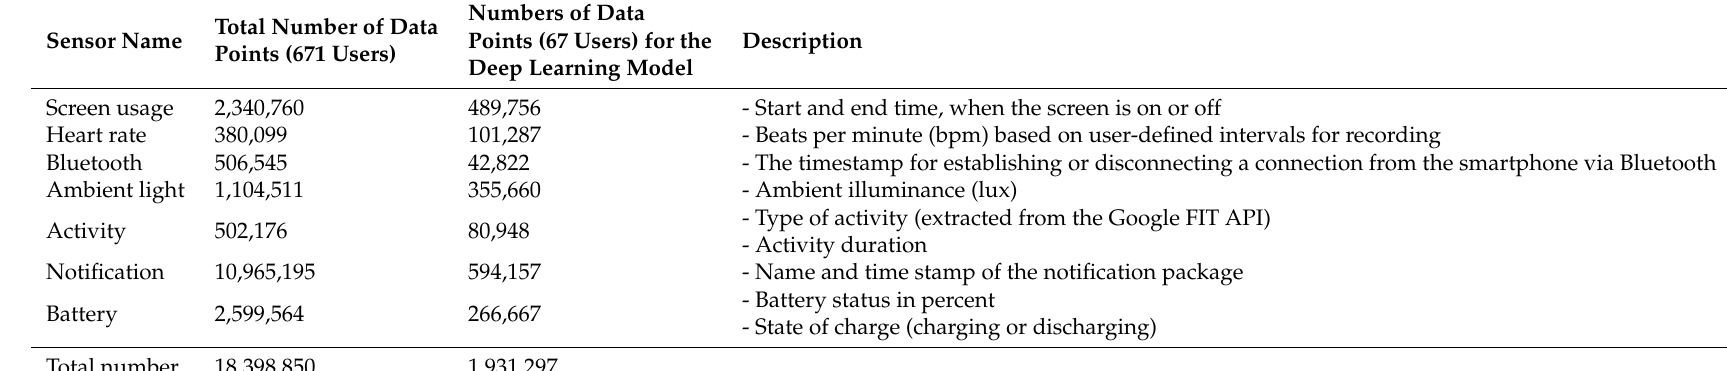
Table 2. Dataset description.